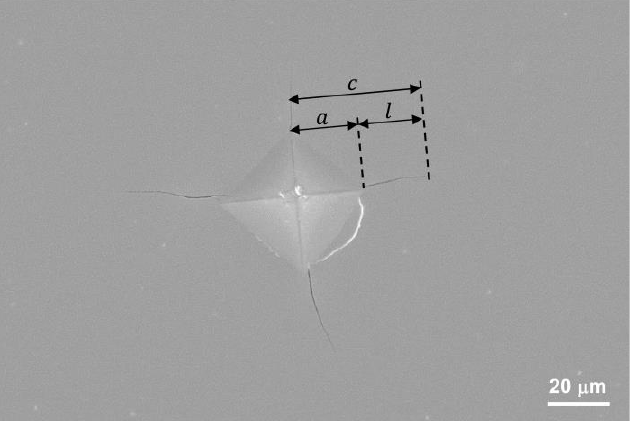
Figure 6. SEM image of an indent obtained from the composite with the highest microhardness by applying a load of 19.6 N. Table 4. Indentation fracture toughness of the composite with the highest microhardness.